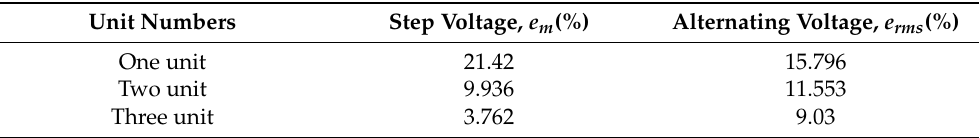
Figure 13. Prediction errors under step voltage excitation for DE membranes with different numbers of Maxwell units: ( a ) the prediction errors, ( b ) The initial 50 s of prediction error. Table 1. Prediction errors at different numbers of Maxwell unit.